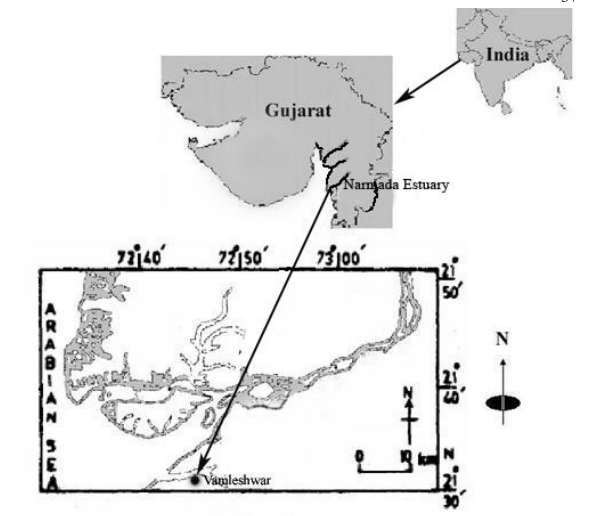
Fig. 1. Location of the study